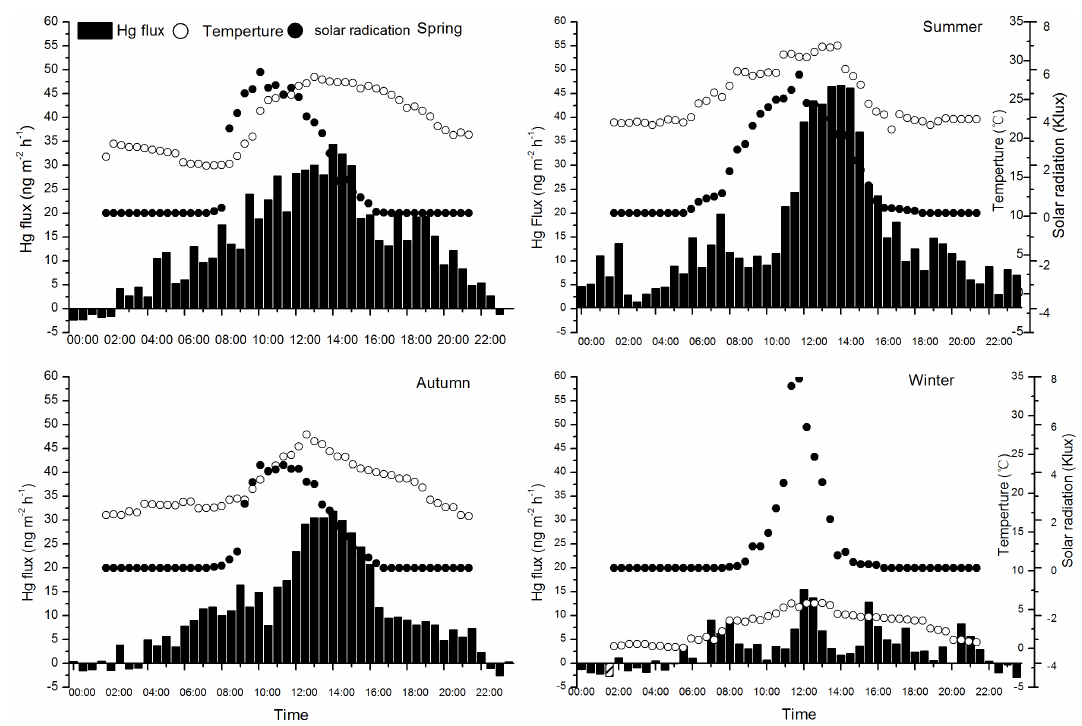
Figure 2. Soil emission fluxes of Hg and air temperature in the evergreen broad-leaf forest field. Spring: 4–16 March, 8–15 May 2012; Summer: 5–12 July, 15–22 August 2012; Autumn: 15–22 September, 20–27 October 2012; Winter: 24–31 December 2012, 6–13